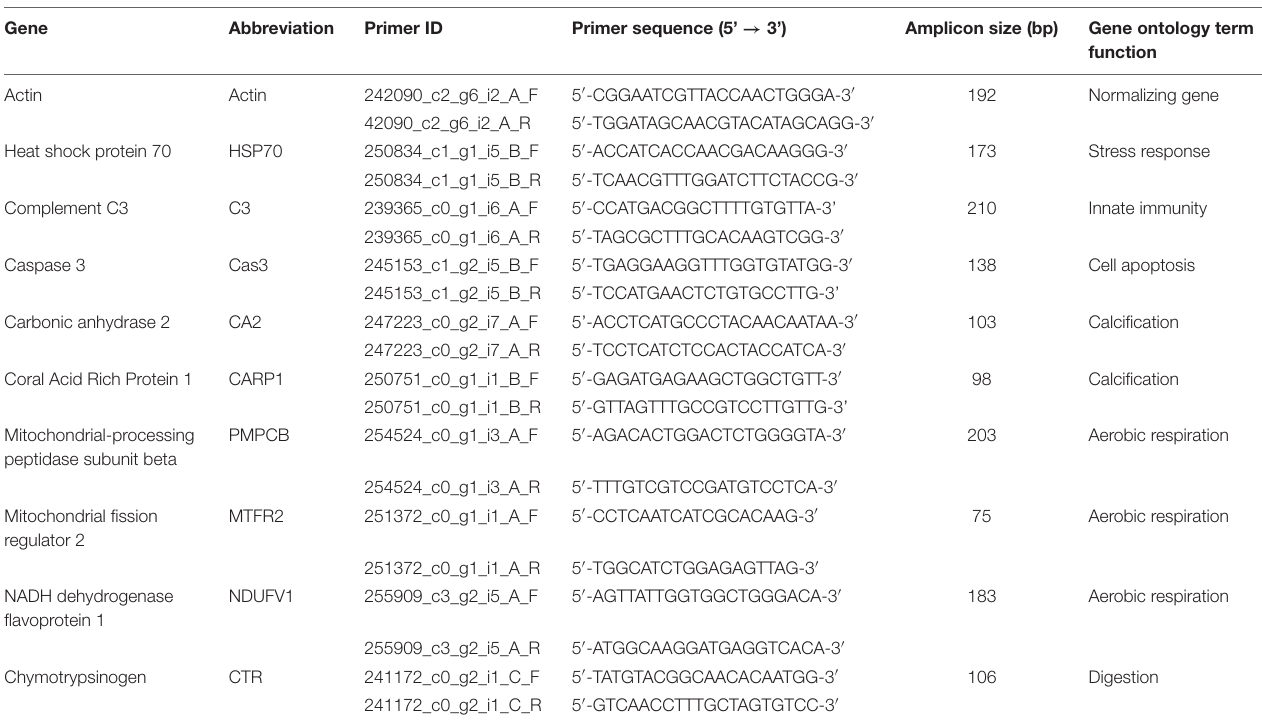
TABLE 1 | Primers list for real-time